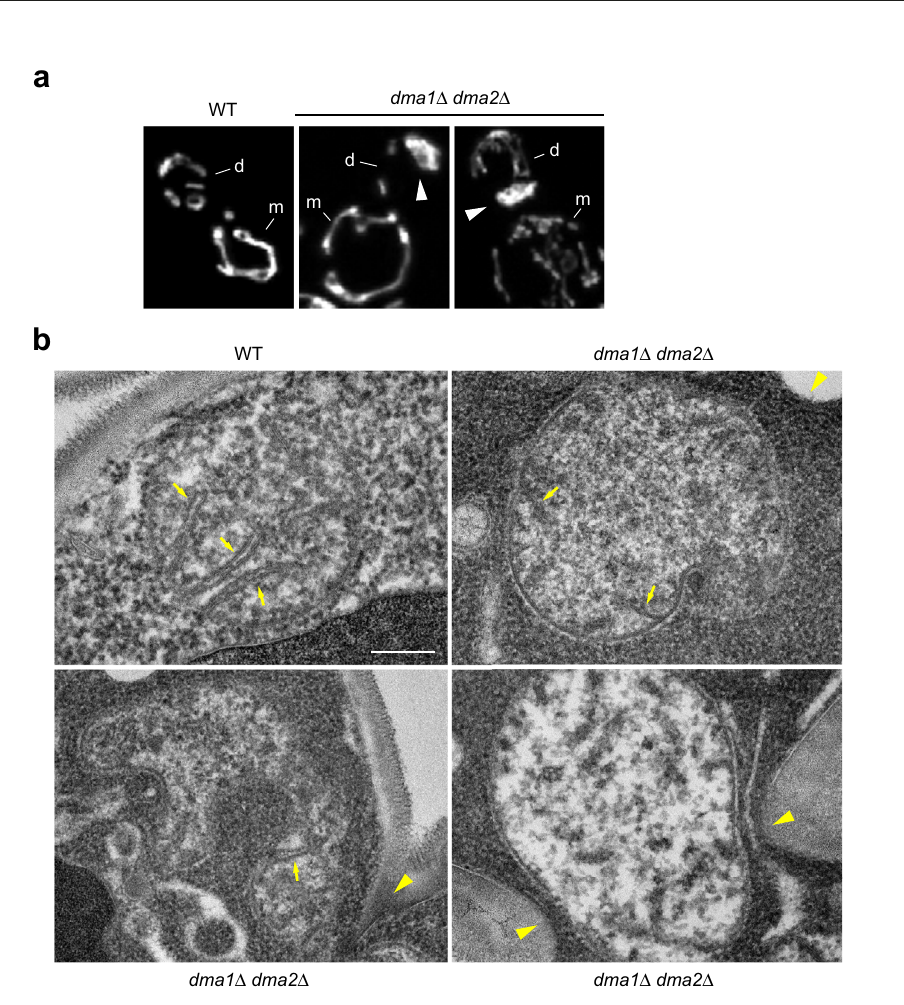
Fig. 3 Dma1 and Dma2 are required for the correct positioning of mitochondria. a YTK5334 ( Mt-GFP ) and YTK5341 ( Mt-GFP dma1 Δ dma2 Δ ) cells grown to log phase in a synthetic complete medium were observed by fl uorescence microscopy. Arrowhead, stacked mitochondria. b Proportion of cells with stacked mitochondria. c Distribution of stacked mitochondria. d YTK5334 ( Mt-GFP ) and YTK5341 ( Mt-GFP dma1 Δ dma2 Δ ) cells grown to log phase in synthetic complete medium were serially observed by fl uorescence microscopy using glass-base dishes. Yellow and white arrowheads, stacked mitochondria at bud tip and the bud neck, respectively. e YOK5303 ( Mt-mCherry MYO2-GFP ) and YOK5304 ( Mt-mCherry MYO2-GFP dma1 Δ dma2 Δ ) cells grown to log phase in synthetic complete medium were subjected to fl uorescence microscopy. White and yellow arrow, co-localization of Myo2-GFP with a part of mitochondria at the bud neck in WT cells and entire mitochondria at the bud neck in dma1 Δ dma2 Δ cells, respectively. Arrowhead, Myo2-GFP co- localized with mitochondria and mislocalized to an abnormal site in dma1 Δ dma2 Δ cells. f YOK5182 ( Mt-mCherry ) and YOK5185 ( Mt-mCherry dma1 Δ dma2 Δ ) cells grown to log phase in YPD medium were fi xed and subjected to F-actin visualization. Yellow arrow, F-actin co-localizing or adjacent to stacked mitochondria at bud neck. g YOK5595 ( Mt-mCherry MMR1-GFP ) and YOK5596 ( Mt-mCherry MMR1-GFP dma1 Δ dma2 Δ ) cells grown to log phase in a synthetic complete medium were observed by fl uorescence microscopy. White arrow, partial co-localization of Mmr1 and a part of mitochondria at the bud neck in WT cells. White arrowhead, co-localization of Mmr1 and tubular mitochondria during transportation to daughter cell. Yellow arrow, accumulation of Mmr1 on stacked mitochondria at bud neck in dma1 Δ dma2 Δ cells. Yellow arrowhead, accumulation of Mmr1 on stacked mitochondria at bud tip in dma1 Δ dma2 Δ cells. Bar, 5 µ m (for all panels). m and d mother and daughter cells, respectively (for all panels). Values in ( b ) and ( c ) represent means ± SDs from three independent experiments. An unpaired two-tailed t test was used for statistical analysis in ( b ). In ( c ), signi fi cance was tested by one-way analysis of variance with Tukey ’ s comparison (values of con fi dence intervals, degrees of freedom, and F are indicated) for each strain. n.s., not signi fi cant. For ( d – g ), similar results were obtained from three independent experiments.